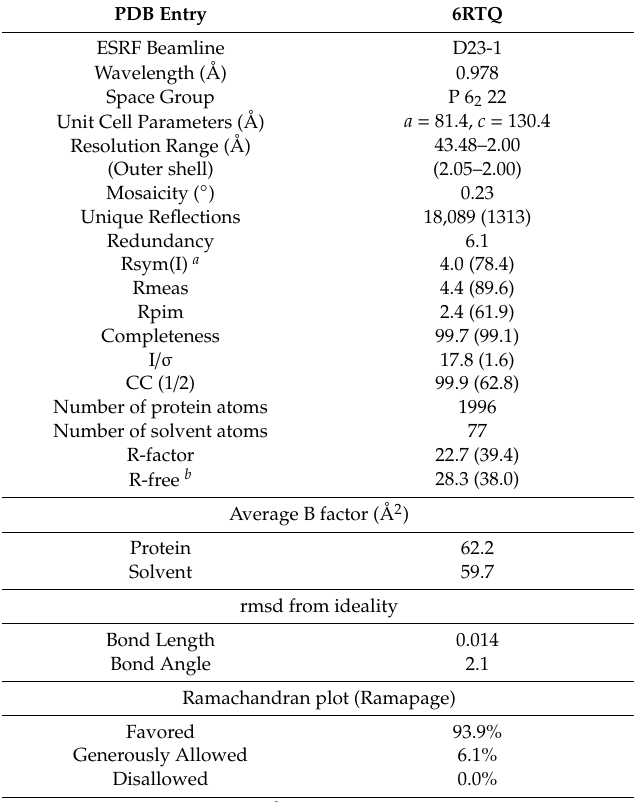
Table 1. Data collection and refinement